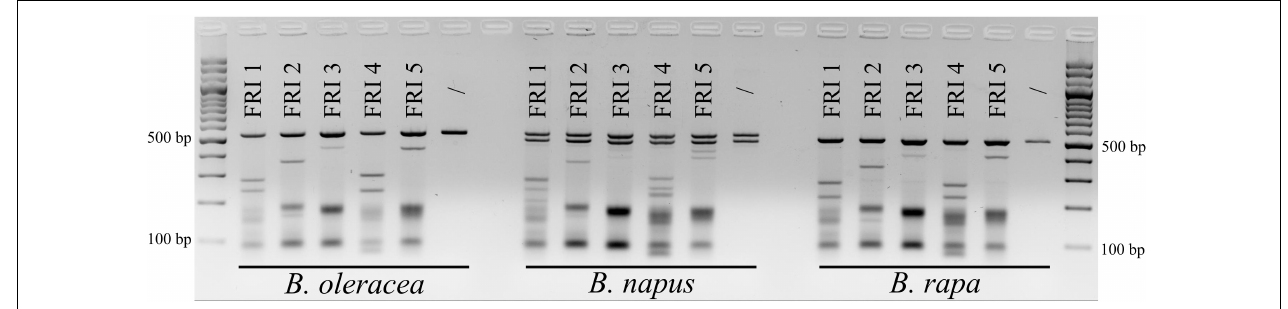
FIGURE 1 | Results of in vitro digestion assay. The gene FRI was PCR-amplified from cabbage ( B. oleracea ), oilseed rape ( B. napus ), and Chinese cabbage ( B. rapa ) DNA and treated with RNPs preassembled with five different sgRNAs (FRI1 to FRI 5). For each species, non-treated samples were used as negative controls (/).